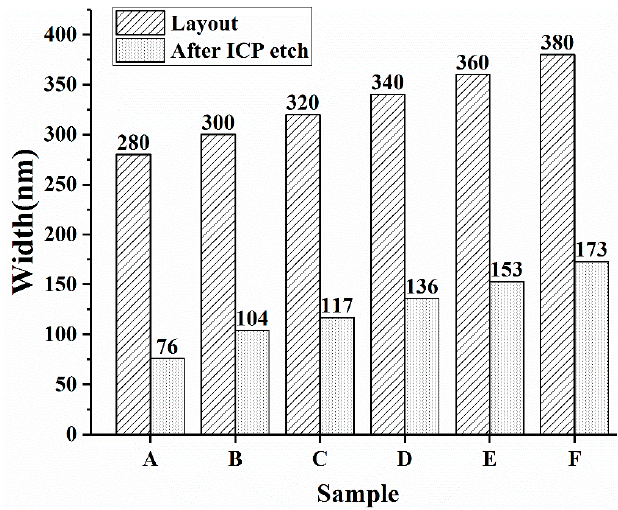
Figure 4. The comparison between the designed layout size and the nanowire width after the ICP